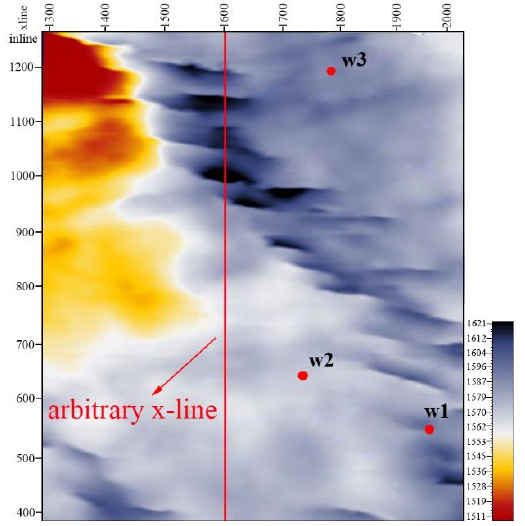
Figure 3. Target horizon map ranging from 1511ms to 1621ms (zoomed-in version of study area contained within the red frame in Figure 2). w1, w2, and w3 are drilled wells; the red line represents an arbitrary x-line for presentation in Figure 4.